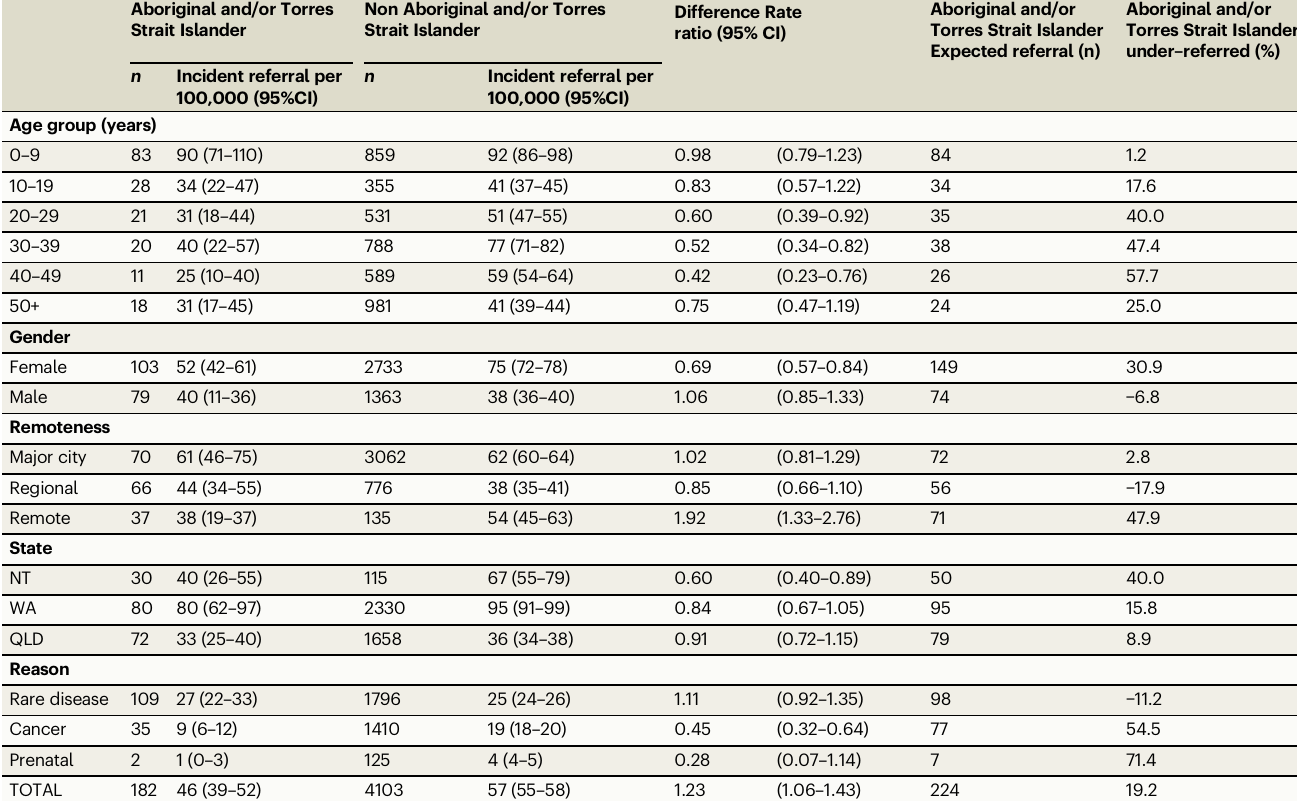
Table 3 | Disparity in annual appointment scheduling for Aboriginal and/or Torres Strait Islander people (univariate analysis) Aboriginal and/or Torres Non Aboriginal and/or Torres Difference Rate Strait Islander Strait Islander ratio (95%